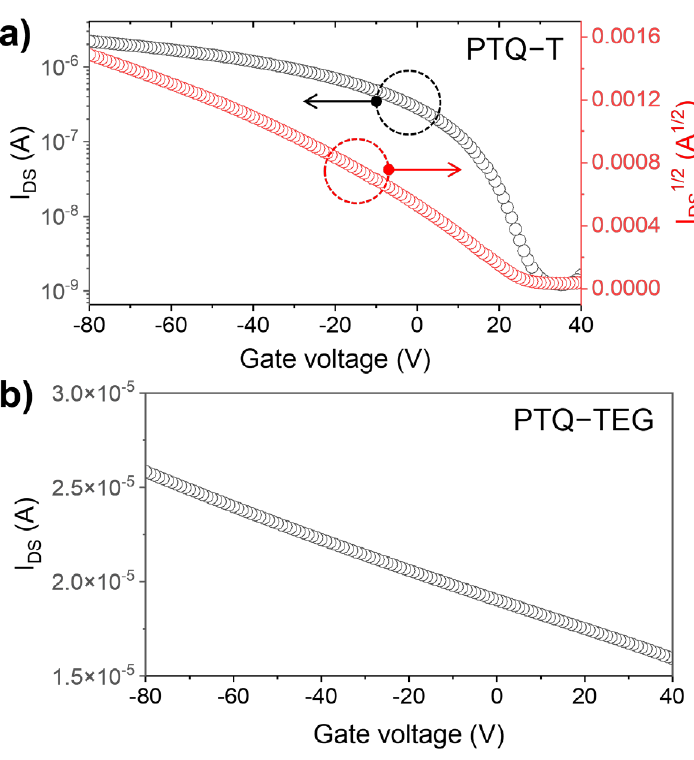
Figure 2. FET curves of ( a ) PTQ-T and ( b ) PTQ-TEG . The distinct electrical properties of PTQ-TEG , compared to PTQ-T, could be due to the contribution of EG-based side chains because both CPs have the same conjugated framework. To ascertain the effect of the EG-based side chain on the electrical proper- ties of PTQ-TEG , the film morphologies and chain assembly features of both CPs were characterized using AFM and 2D-GIXRD, respectively, because the electrical properties of CPs are known to be sensitively affected by the degree of chain aggregation and as- sembly [49,50]. As shown in Figure 3a,b, both CPs exhibited featureless smooth surfaces with root-mean-square (RMS) roughness values of 0.478 nm and 0.355 nm for PTQ-T and PTQ-TEG , respectively. Compared to PTQ-T , PTQ-TEG showed a slightly reduced RMS roughness. The reduced RMS roughness can be attributed to the enhanced fluidity of the EG-based side chain, which has a lower rotational barrier energy than the alkyl side chain. In addition, the chain assembly tendencies of the CPs in the film state